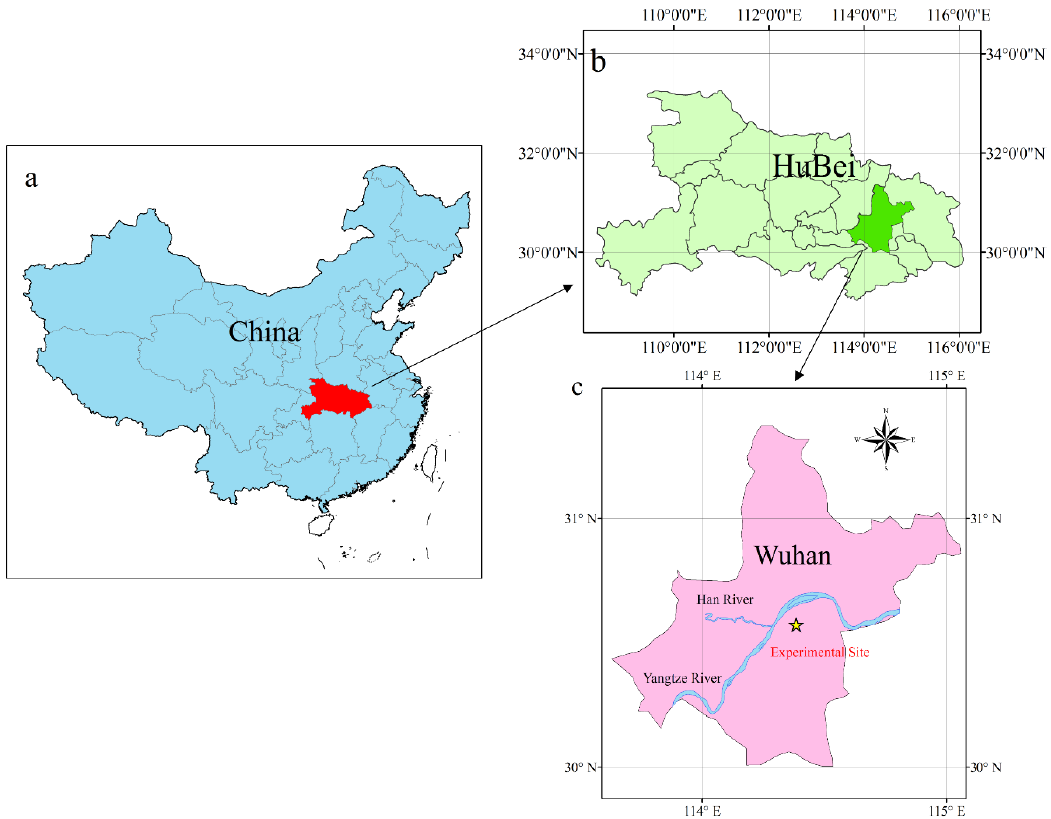
Figure 1. Location of the sampling site: ( a ) location of Hubei Province, China; ( b ) location of Wuhan in Hubei Province and ( c ) location of the experimental site in Wuhan.